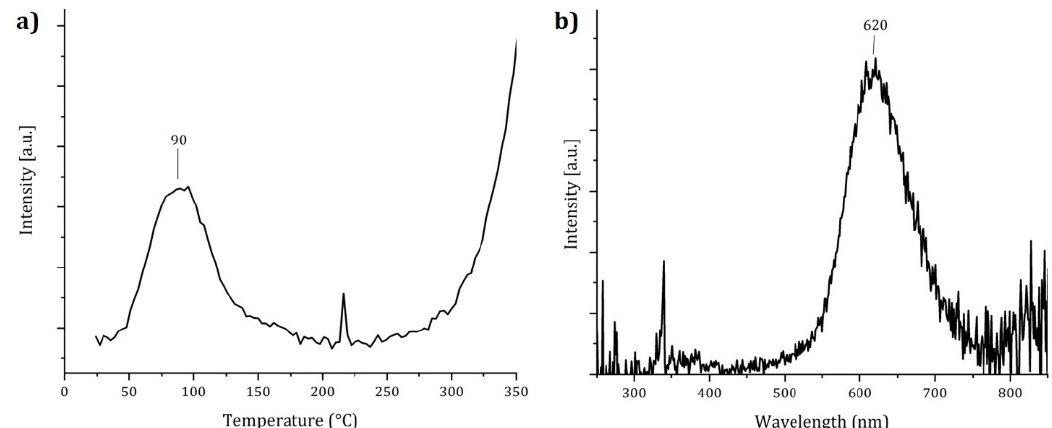
Figure 7. WR-TL experiment on Q_LS. ( a ) The glow curve obtained integrating the data between 550 nm and 650 nm, showing a single TL peak at around 90 °C. The intensity observer at the higher temperatures is from the black body radiation of the heater. ( b ) The emission spectra obtained by integrating the data between 60 °C and 125 °C, showing a single dominant emission at around 620 nm.